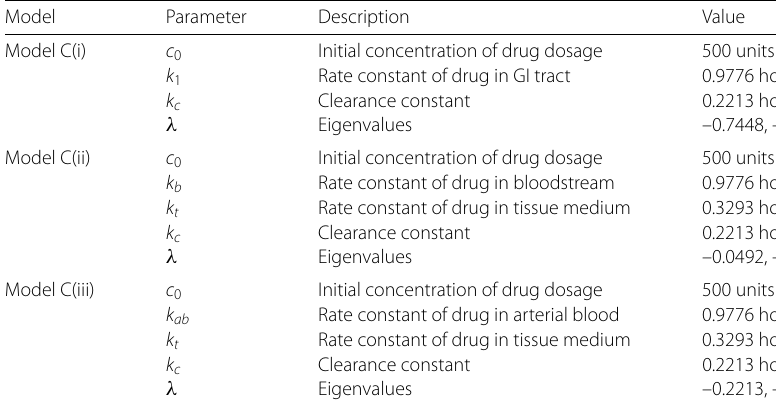
Table 3 Model parameter values in Models C(i), (ii), and (iii) for t ∈ [0,6] Model